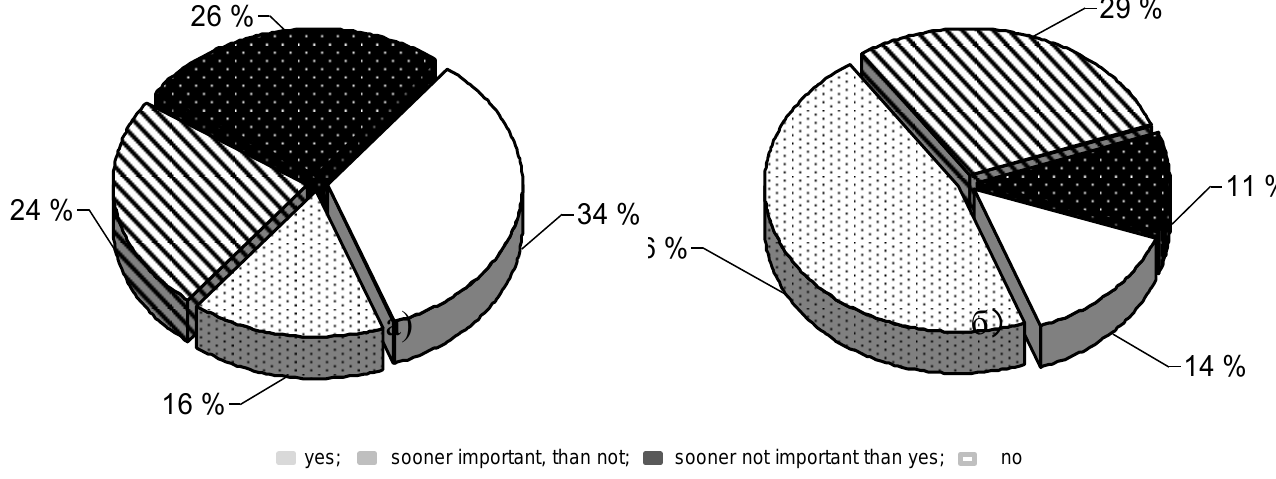
Fig.4. Application of individualized approach during psychological training in training sessions of different classes’ tennis players (by experts’ data,